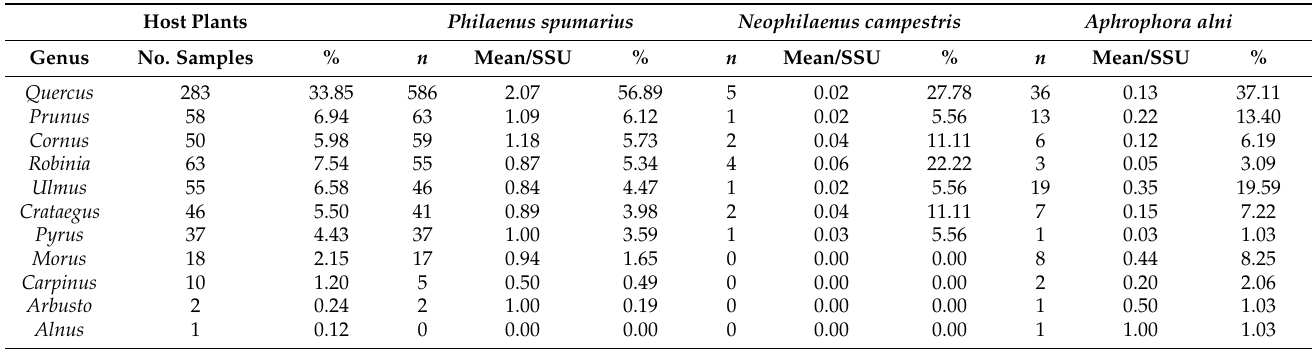
Table 2. The abundance of spittlebug adults (total and mean individuals/SSU) on genera of wild woody plants in the surroundings of the Asti vineyard in 2016–17